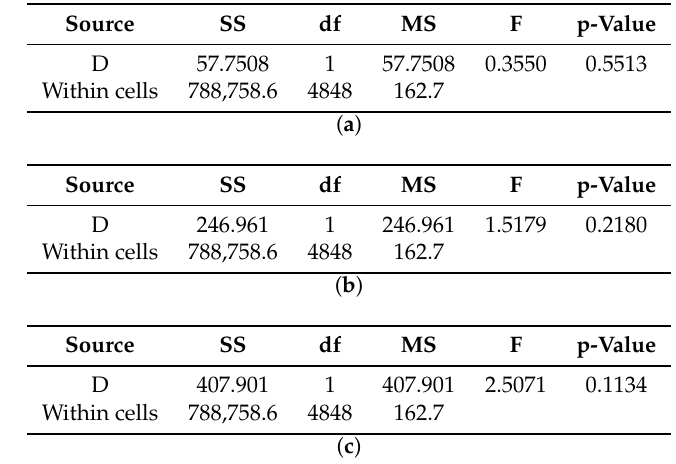
Figure A34. ANOVA tables for the analysis of the effect of factor D (speed of the obstacle) on the convergence. ( a ) One-way ANOVA for factor D given B = 1 and C = 1. ( a ) One-way ANOVA for factor D given B = 1 and C = 2. ( a ) One-way ANOVA for factor D given B =